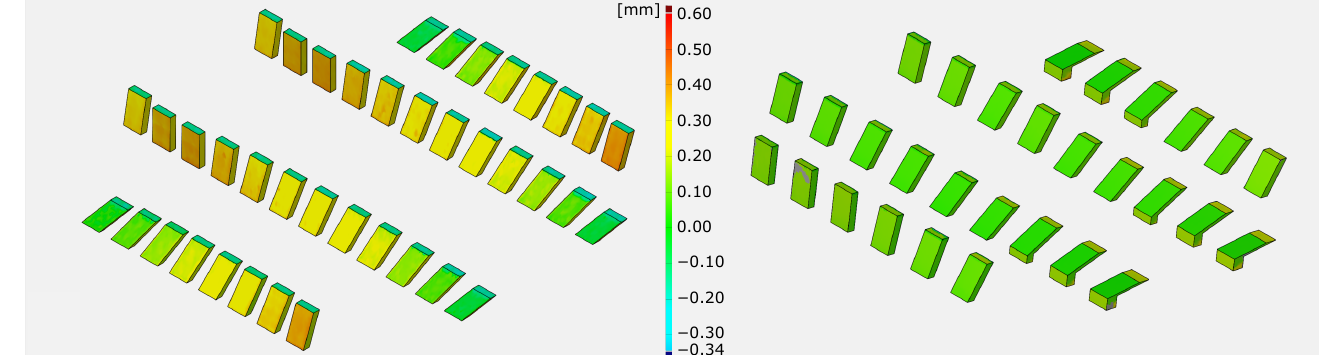
Figure 8. Comparison of SLM –built ( left ) and hybrid manufactured ( right ) inclinations (false colour